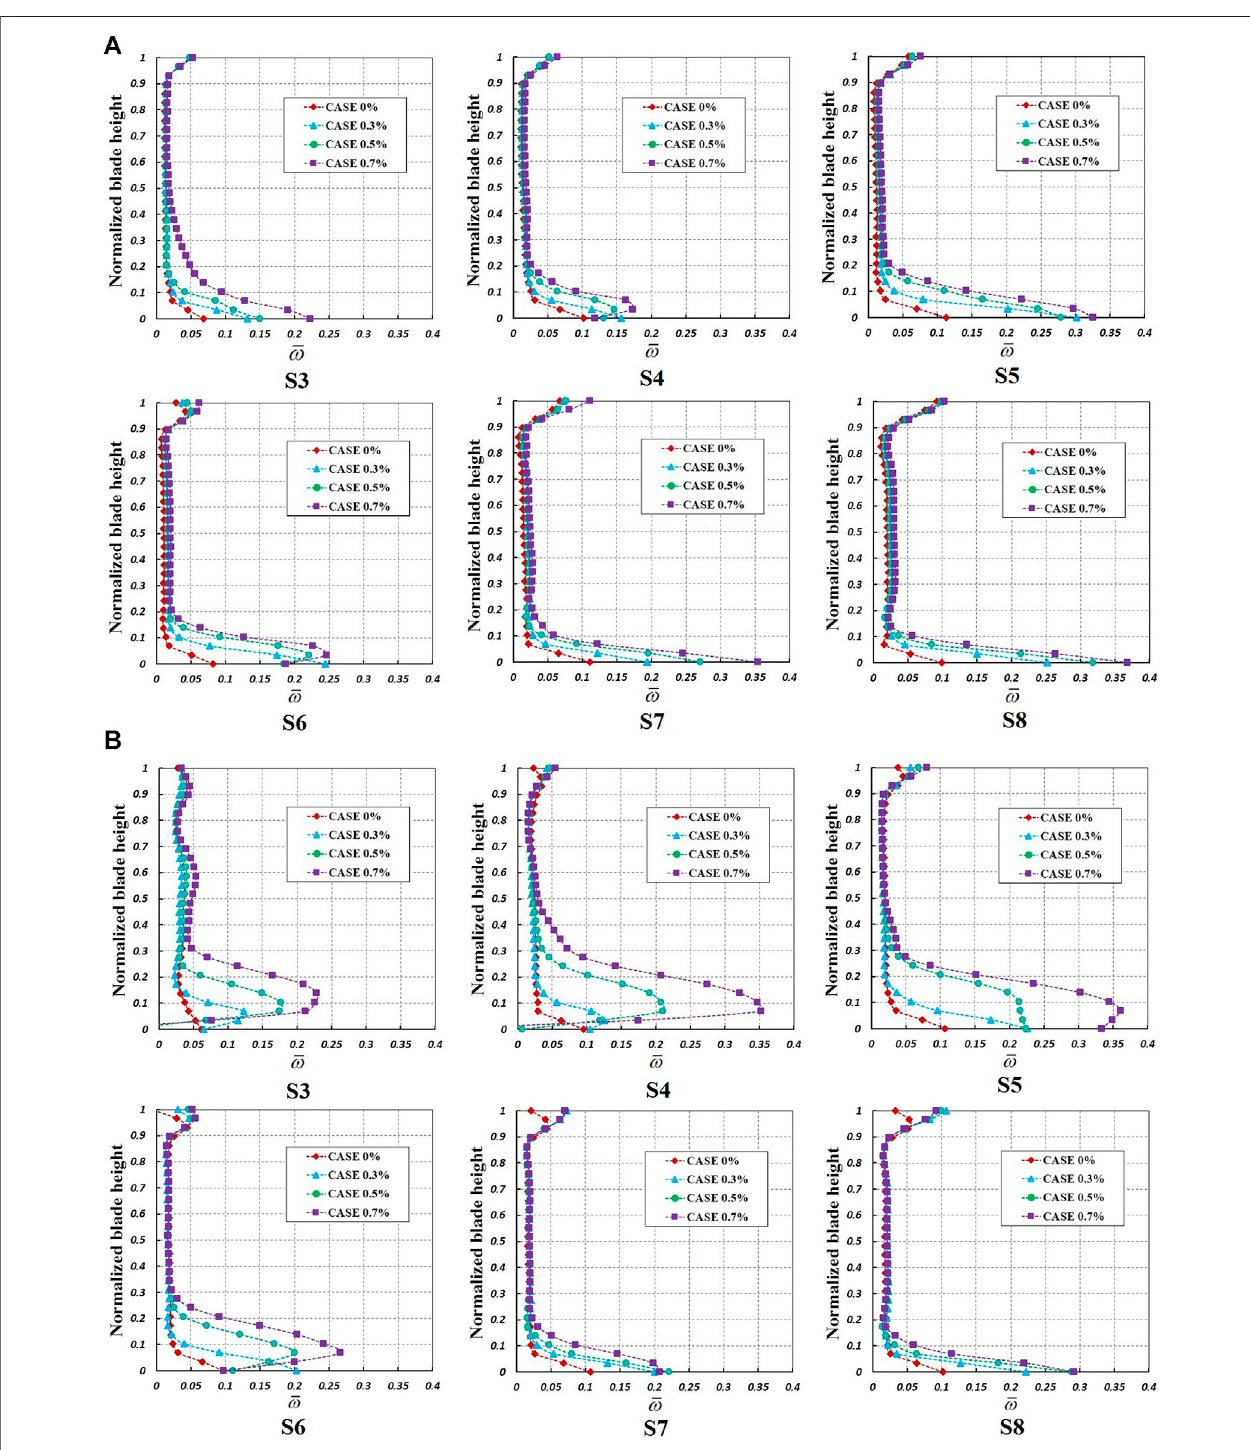
FIGURE 9 | Distribution of (cid:1) ω at each stator along its span at the design point of 100%n (A) , The nearest stall point of 75%n (B) .